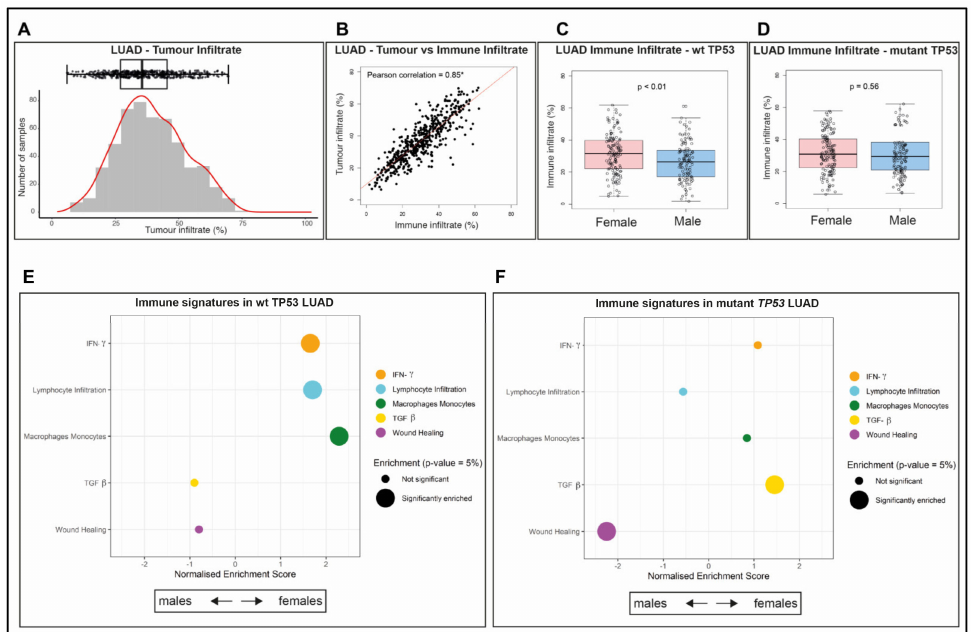
Figure 2. Female LUAD is highly immune infiltrated and enriched for specific immune signatures. ( A ) Proportion of tumor infiltrate in each TCGA LUAD sample. ( B ) Correlation between the proportion of tumor infiltrate and immune infiltrate in these samples. A Pearson correlation coe ffi cient with the symbol * indicates the correlation is significantly di ff erent from 0, using the Spearman’s test of significance (p- value < 0.05). Proportion of immune infiltrate for females compared to males in LUAD samples with either ( C ) wt TP53 , p -value < 0.01, or ( D ) mutant TP53, p -value = 0.56, using analysis of variance (ANOVA) to measure significance ( p- value < 0.05). Gene Set Enrichment Analyses (GSEA) for immune signatures analyzing di ff erentially expressed genes in LUAD females relative to males with ( E ) wt TP53 or ( F ) mutant TP53. Significantly enriched immune signatures ( p -value < 0.05) are denoted by a large